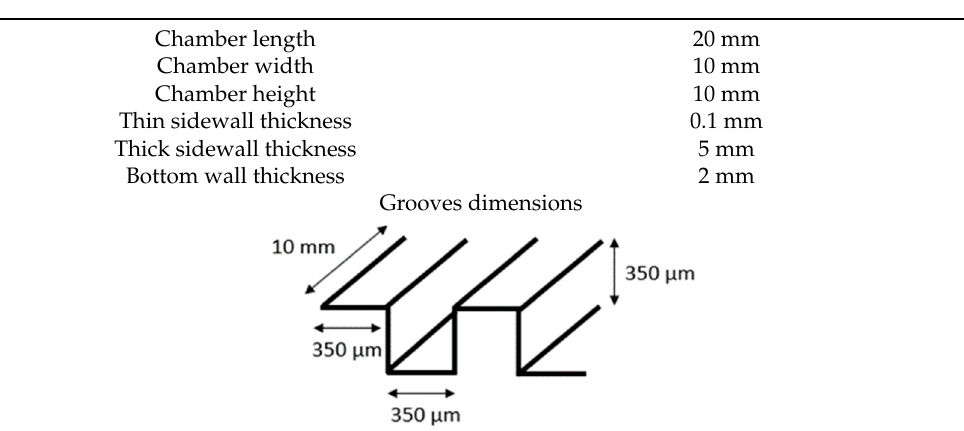
Table 2. PDMS chamber dimensions.